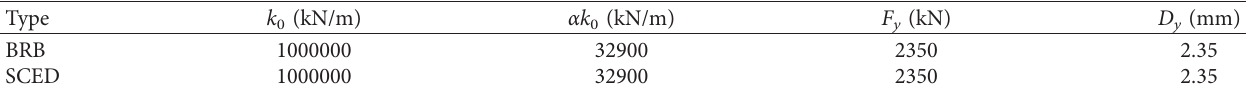
Figure 12: Restoring force curve: (a) SCED; (b) BRB. Table 6: The mechanical parameters of the